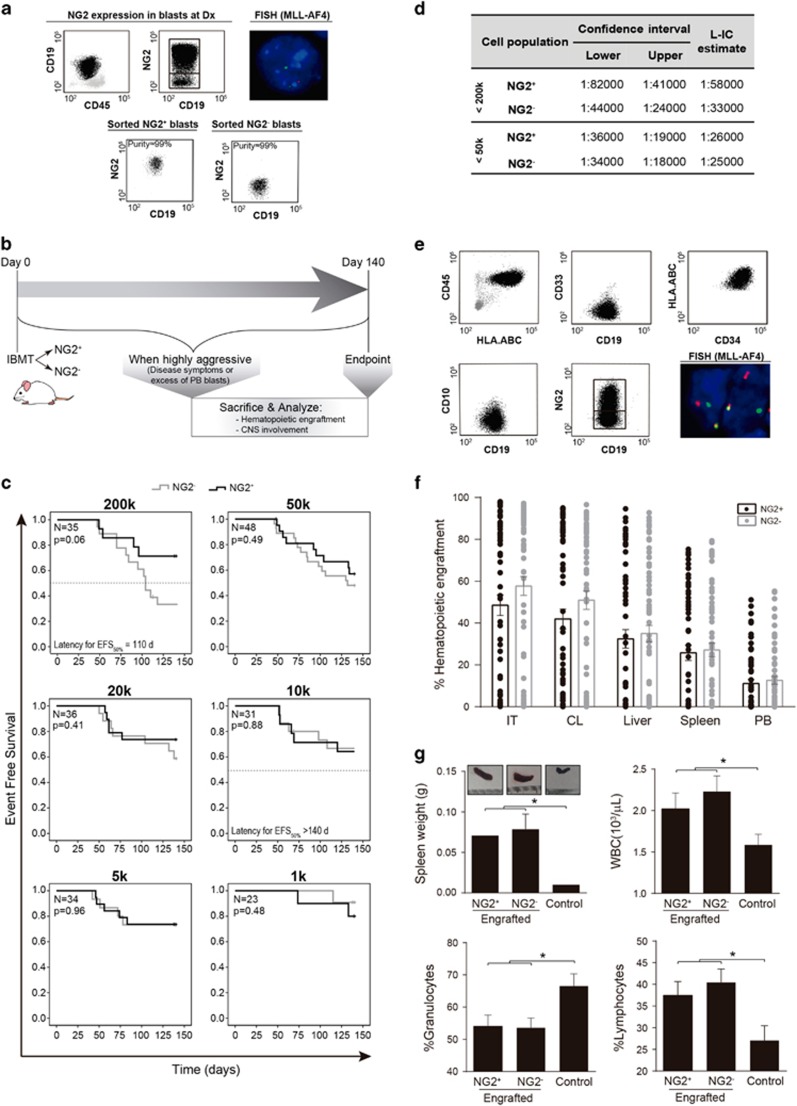
Leukemia development and phenotype in primografts of NG2+ and NG2− blast populations. (a) Representative NG2 immunophenotype of diagnostic MA4+ BM samples and high-purity FACS-sorting of NG2+ and NG2− populations. More than 95% of NG2+ and NG2− blasts carry the t(4;11)/MA4 by fluorescence in situ hybridization (FISH). (b) Outline of the in vivo experimental design. NG2+ or NG2− blasts were IBM-transplanted into NSG mice at day 0. The health of the mice and leukemia development were monitored over 20 weeks. Mice were killed when disease was evident, when leukemic cells were 10% in PB or at day 140 (in the absence of symptoms or PB engraftment). (c) Kaplan–Meier survival curves for EFS according to decreasing cell doses (200k to 1k) for NG2+ and NG2− transplanted mice (n=245). (d) Estimated frequency (and 95% confidence interval) of L-IC in NG2+ and NG2− primografts calculated for cell doses <200k or <50k. (e) Representative flow cytometric analysis of leukemic mice. The human graft, identified as CD45+HLA-ABC+, reproduces the pro-B phenotype (CD34+CD19+CD10−) seen in patients. Engrafted leukemias always re-establish NG2 variable expression and carry the t(4;11)/MA4 as detected by dual-fusion or break-apart FISH. (f) Level of leukemia engraftment in hematopoietic tissues from mice transplanted with NG2+ and NG2− blasts. Each dot represents a transplanted mouse and bars represent mean level of engraftment. (g) Both NG2+ and NG2− transplanted mice consistently displayed splenomegaly, high WBC counts and a skewed granulocytic-to-lymphoid cell representation in PB. Control group includes non-engrafted mice. *P<0.05.